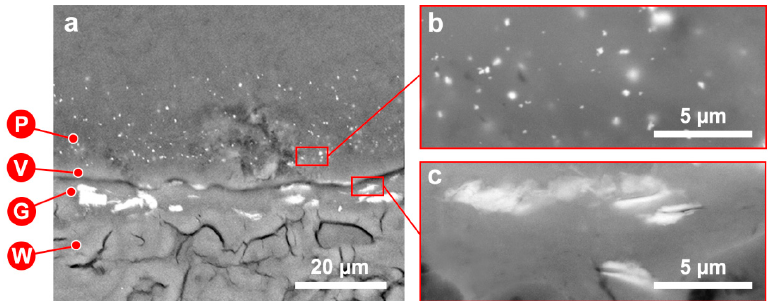
Figure 3. BSE-SEM images of the mock-up m.D ( a ), with hematite ( b ) and talc ( c ) particles at higher magnifications highlighted in red rectangles. Letters refer to the stratigraphic layers (P: